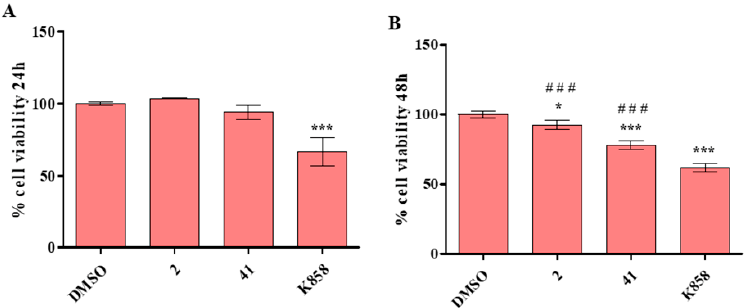
Figure 4. MTT test on HGF cells exposed to 2 (1.5 μ M), 41 (5 μ M), and K858 (10 μ M) for 24 ( A ) and 48 h ( B ). Metabolic activity was normalized to DMSO-treated cells (0.2% as final concentration). DMSO: control vehicle. Data shown represent the mean ± SD of three independent experiments. ( A ): *** p < 0.0001 DMSO vs. K858. ( B ): *** p < 0.0001 DMSO vs. Eg5 inhibitors; * p < 0.01 DMSO vs. Eg5 inhibitors; ### p < 0.0001 K858 vs. 2 and 41 .